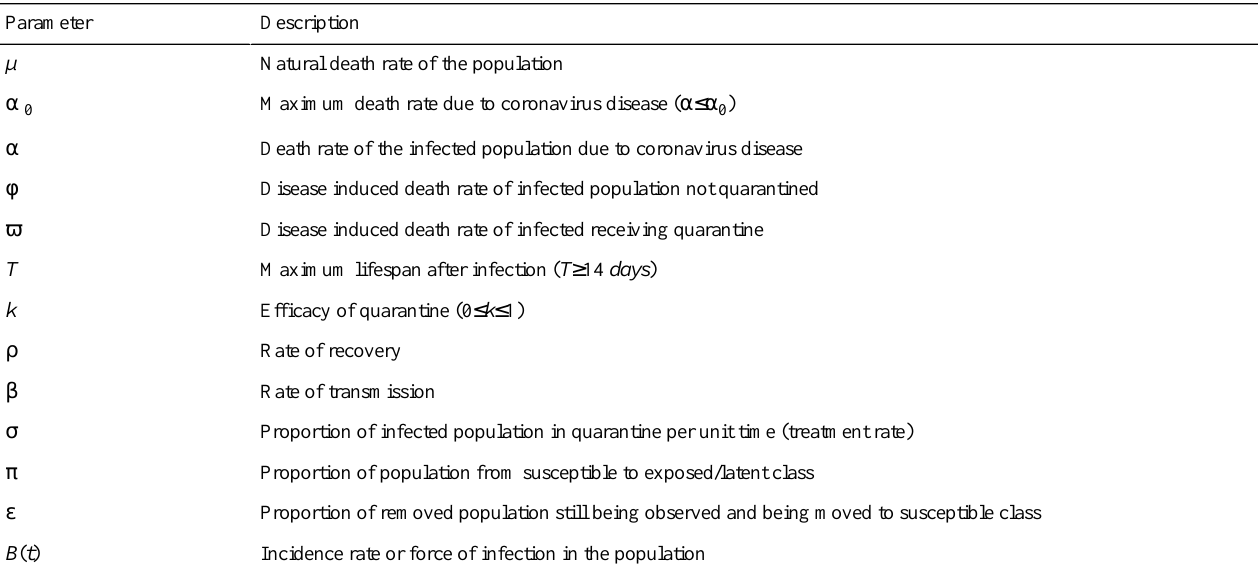
Table 2. The parameters for the new deterministic endemic